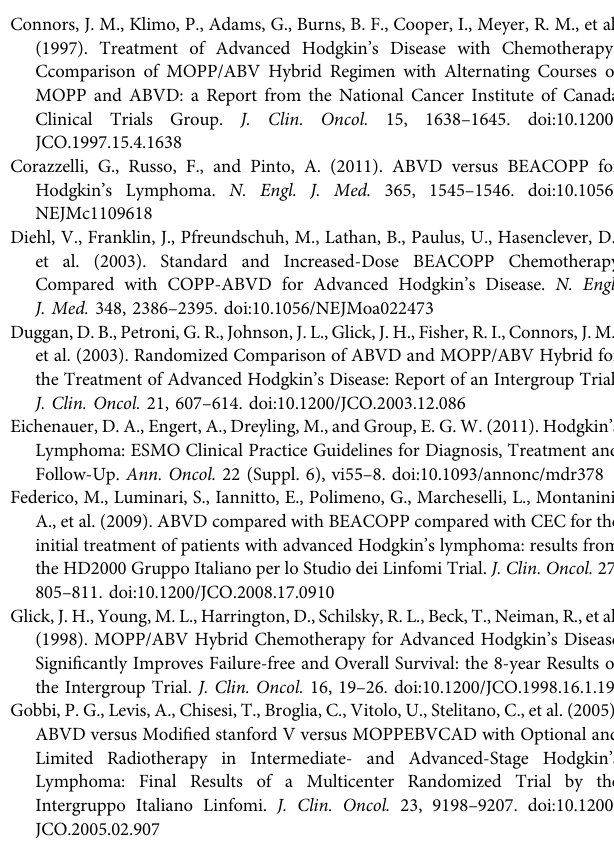
Supplementary Figure S1 | Flow chart showing literature search and study selection. Fifteen randomized controlled trials met the inclusion criteria and were included in this